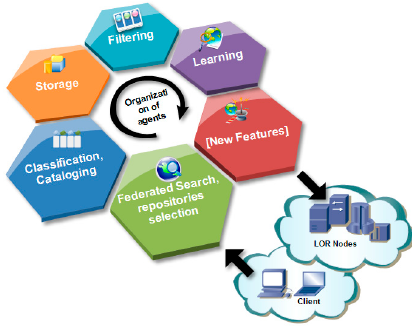
Figure 1. Distribution of tasks in the architecture for intelligent retrieval of educational content from heterogeneous environments (AIREH) architecture. heterogeneous environments (AIREH)